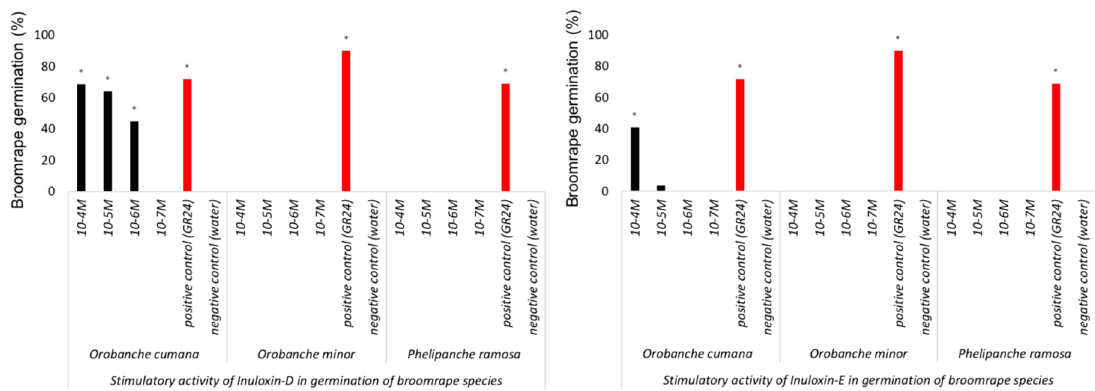
Figure 3. Orobanche cumana , Orobanche minor , and Phelipanche ramosa germination induced by inuloxin D (left panel) and inuloxin E (right panel). The asterisk (*) indicates differences at the 0.05 level compared with the negative control (seeds induced to germinate with water).